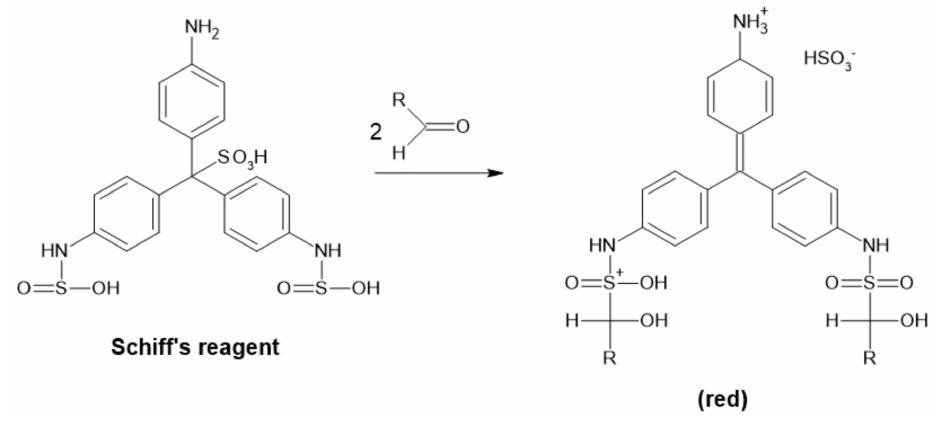
Figure 14. Detection of aldehyde by Schiff’s reagent.